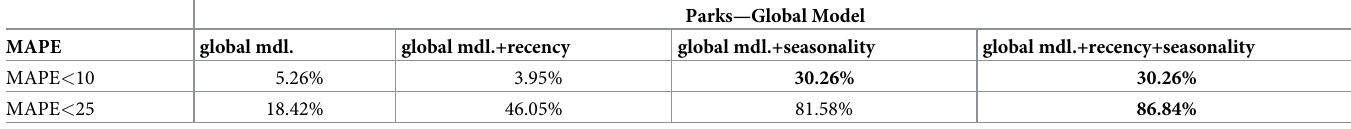
Table 15. Prediction results adopting seasonality and/or recency tourism requirements for a global model trained with 76 national parks in U.S. (outdoors). The best prediction models are in bold face. MAPE global